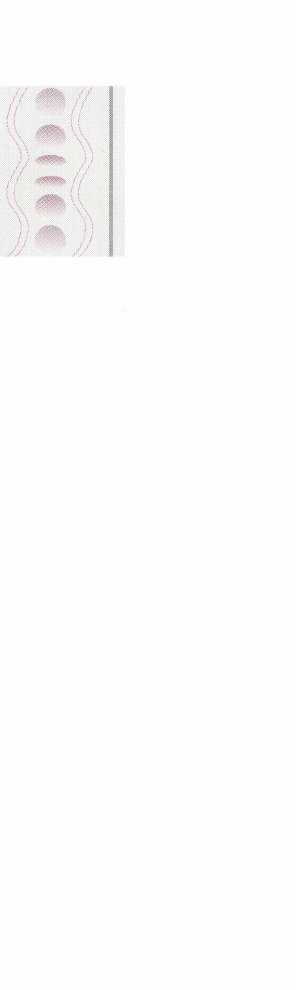
Fig. 3: Stationary deformation (A/Aoistat of a droplet (x � 500 �m) in silicone oil 10.54 lllk =